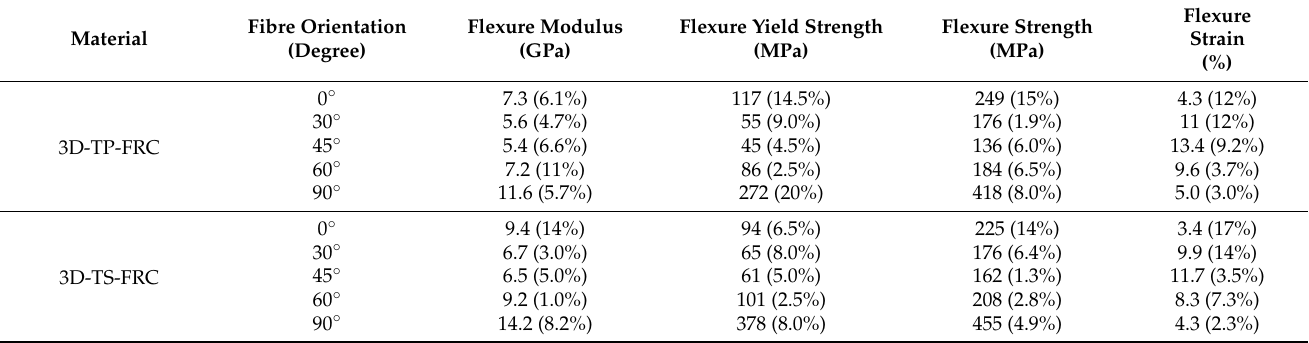
Table 2. Summary of flexure test results. Value in the parenthesis represents the co-efficient of variance in